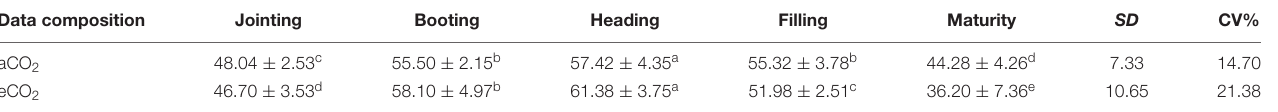
TABLE 2 | The chlorophyll content of winter